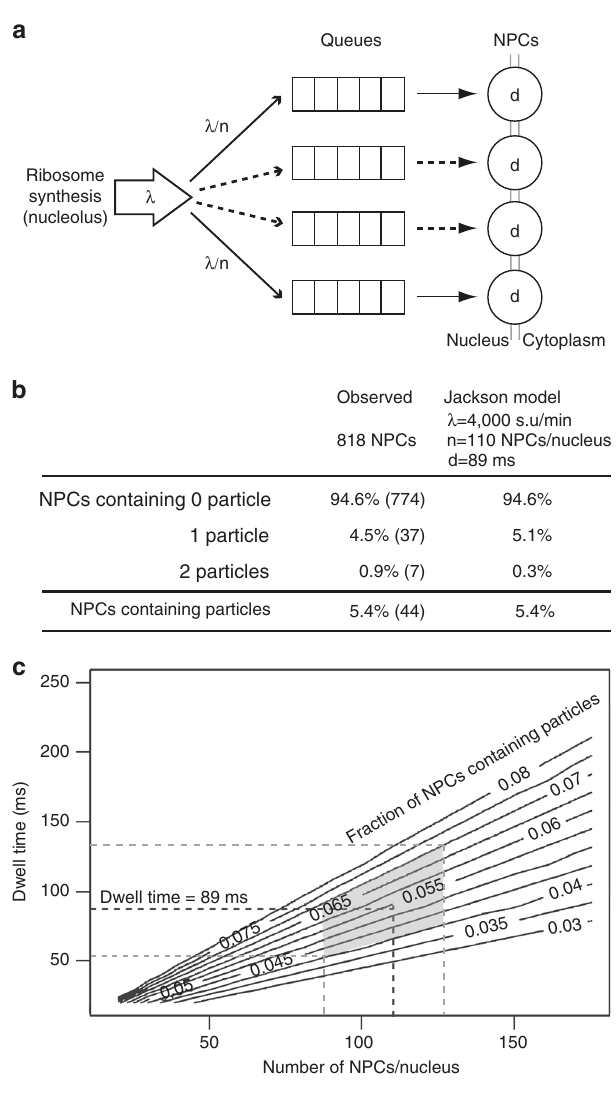
Fig. 5 Determination of the dwell time of pre-ribosome in NPCs by a probabilistic method. a Nuclear export of pre-ribosomes was modeled according to a Jackson queueing network. Each NPC is characterized by a queue and a dwell time. We assume that pre-ribosomes are routed to NPCs with equal probability, which is supported by the even distribution of pre- ribosomes among nucleolar and nucleoplasmic NPCs. b Based on an average of 110 NPCs per cell and a fl ux of 4000 pre-ribosomal particles/ min, the best fi t of the model to the experimental data (5.4% of occupied NPCs) is obtained for a dwell time of 89 ms. The values predicted by the Jackson model correspond to NPCs with no particle, containing one particle, or occupied by one particle with one particle in the queue. c The robustness of this estimated dwell time was tested considering combined errors in the average number of NPCs (110 ± 20) and the observed NPC occupancy rate (5.4 ± 1.5%). The gray polygon delimits the domain de fi ned by these values. The dwell time in this domain ranges from 55 to 140 (Fig. 5a). At equilibrium, the probability that a NPC is occupied by a cargo depends on the fl ux of cargoes, the total number of NPCs and the dwell time. Ribosome synthesis in S. cerevisiae was previously estimated at 2000 ribosomes/min during the expo- nential growth phase 33 , which implies export of 4000 subunits/ min from the nucleus. We made the approximation that the fl ux of pre-ribosomes is constant throughout the cell cycle. The number of NPCs per nucleus was found previously to vary from